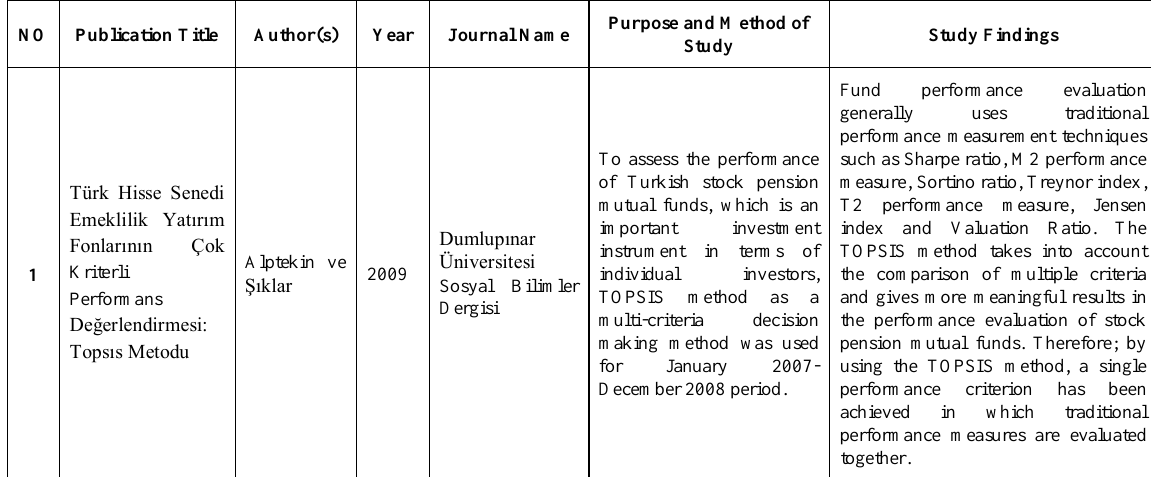
Table 1: The Evaluation of Business Performance by Using TOPSIS Method and Ratio